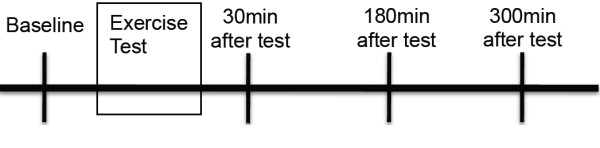
Schematic flow chart of the study design. Blood was taken before the exercise and 30 min, 180 min and 300 min after exercise testing.